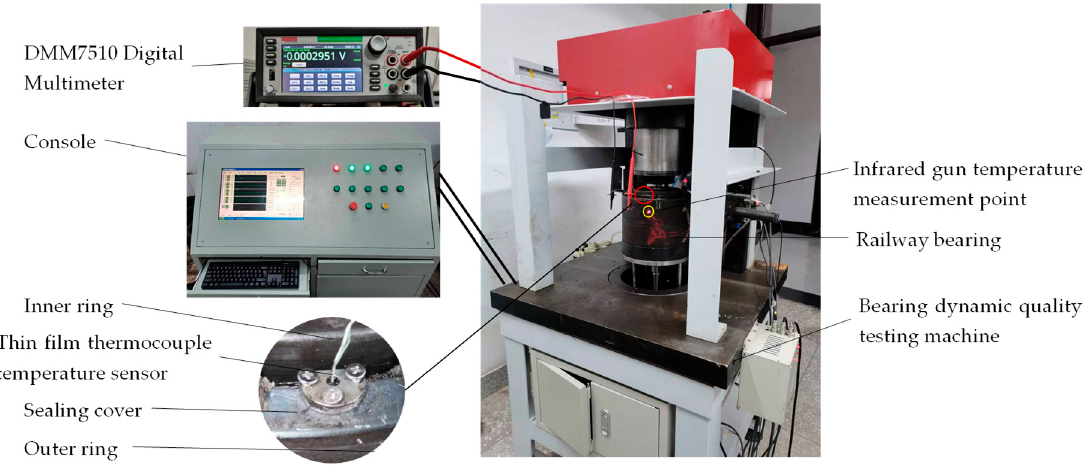
Figure 15. Railway bearing temperature measuring device.